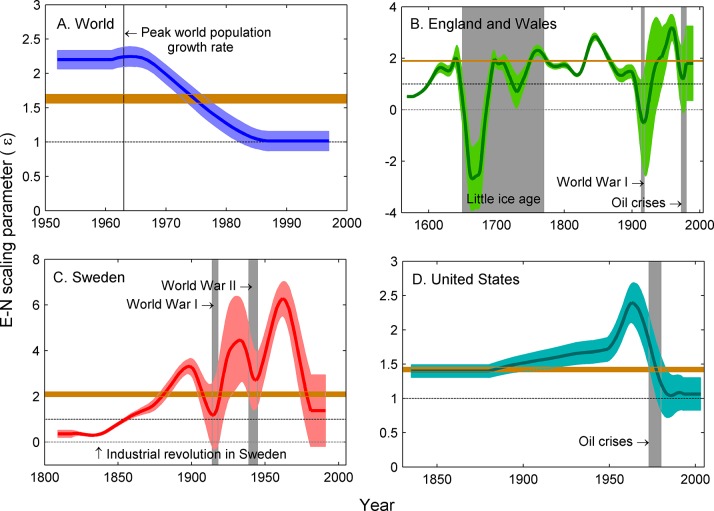
The scaling parameter for ε has been highly variable through time.Each panel shows the running mean of ε (slope of the regression of logE on logN, see methods) with a 19-year window smoothed over 20 years. The light brown bar shows the confidence range of mean slope over the entire time period. A. For the world, ε showed a pronounced shift from a little over 2 to 1 from the 1960’s to the 1980’s, with the beginning of this decline coinciding with the peak world population growth rate in 1963 [9]. B. For England and Wales, ε was highly variable, plummeting during the Little Ice Age and during World War I and the Oil Crises of the 1970s. C. Sweden showed an increase in ε after the Industrial Revolution but also showed a decline in ε during both world wars. D. The United States showed a steadily increasing e until about the 1960s when it showed a severe drop coinciding with the Oil Crises of the 1970s.